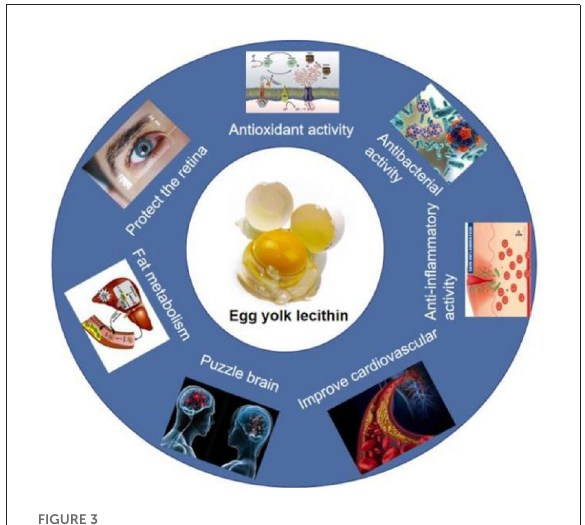
FIGURE3 Physiologic function activity of egg yolk